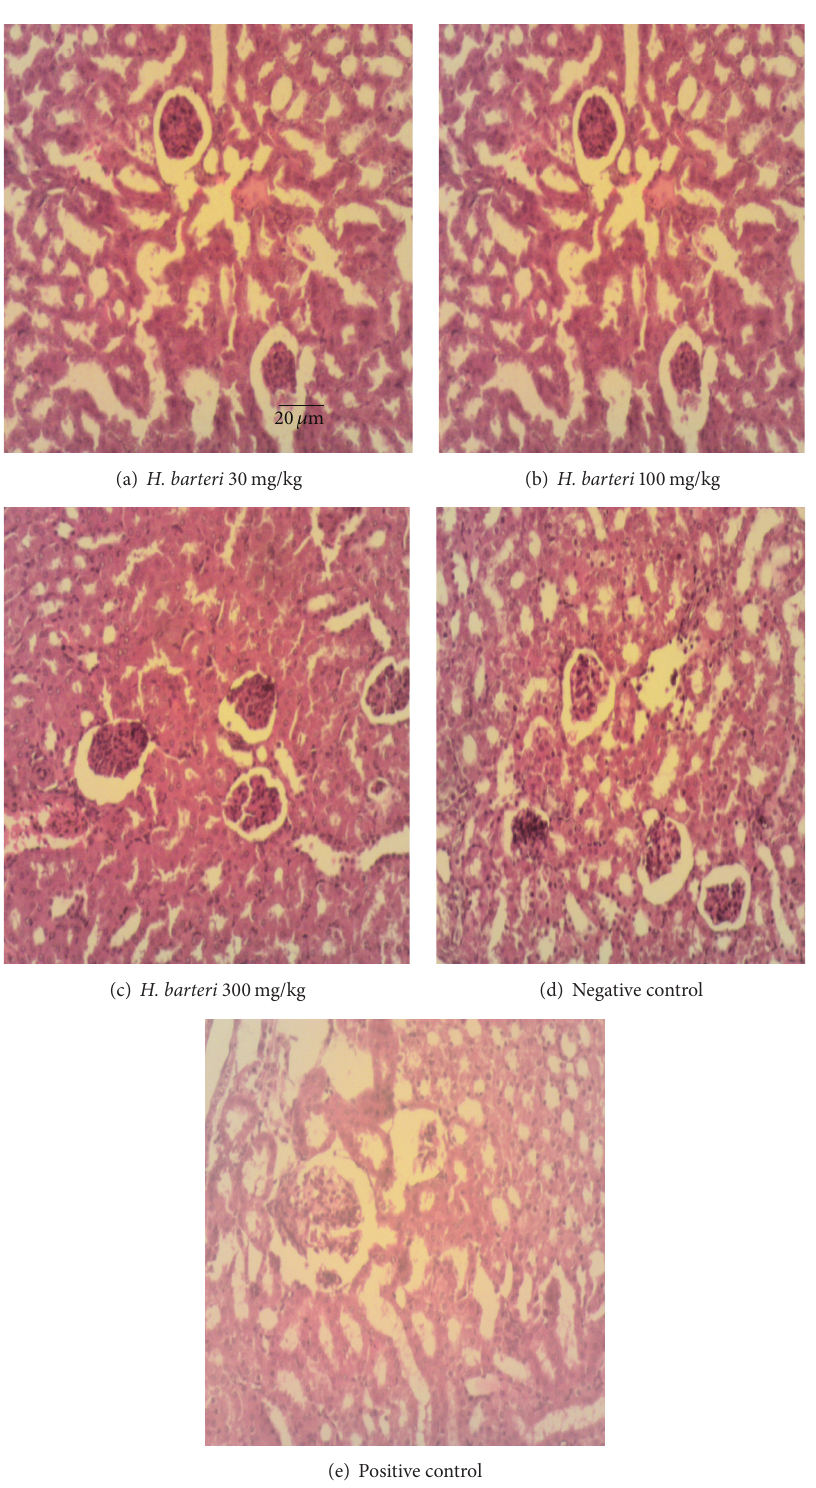
Figure 2: Pictures of kidneys under high magnification (100x). (a) H. barteri (30mg/kg), extract treated kidney: mildly reduced tubular nephrosis; (b) H. barteri (100mg/kg), extract treated kidney: mild pathological changes and renal cortical congestion; (c) H. barteri (300 mg/kg), extract treated kidney: slightly edematous, wider capsular space and few basophilic cells; (d) negative control kidney: severe tubular nephrosis and perivascular interstitial mononuclear cell infiltration; (e) positive control (artemether/lumefantrine) treated kidney: mild pathological